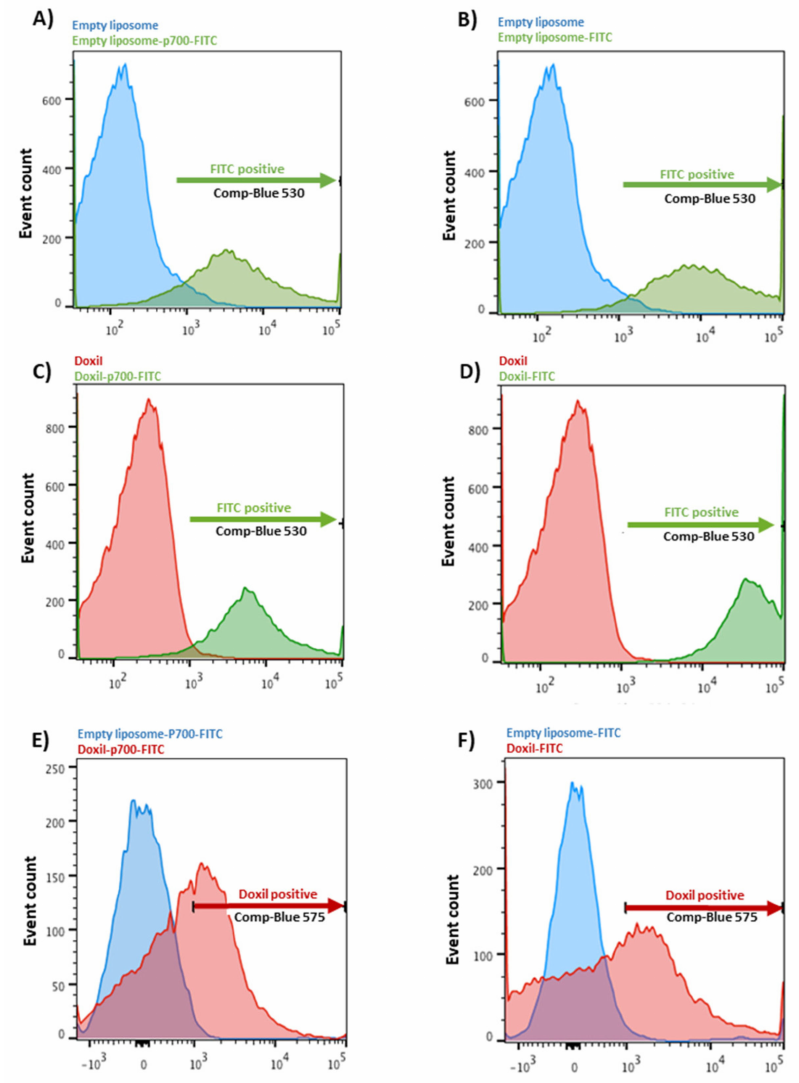
Figure 1. Assessment of p700 coupling to PEGylated liposomes. Flow cytometric analysis of coupling of: ( A ) empty DBCO-liposome to azido-p700-FITC; ( B ) empty DBCO-liposome to azido-FITC only; ( C ) DBCO-Doxil to azido-p700-FITC; ( D ) DBCO-Doxil to azido-FITC only. Panels ( A – D ) show the shift in green (FITC) fluorescence before (blue or red peaks) and after (green peaks) coupling. Panels ( E ), for p700-FITC and ( F ), for FITC-only, compare the red (doxorubicin) fluorescence of the empty liposomes (blue peaks) versus Doxil (red peaks) following coupling, confirming the presence of doxorubicin in the coupled